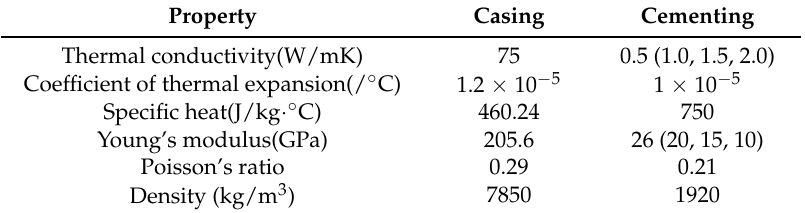
Table 6. Thermal and mechanical properties of casing and cementing adopted in the model.